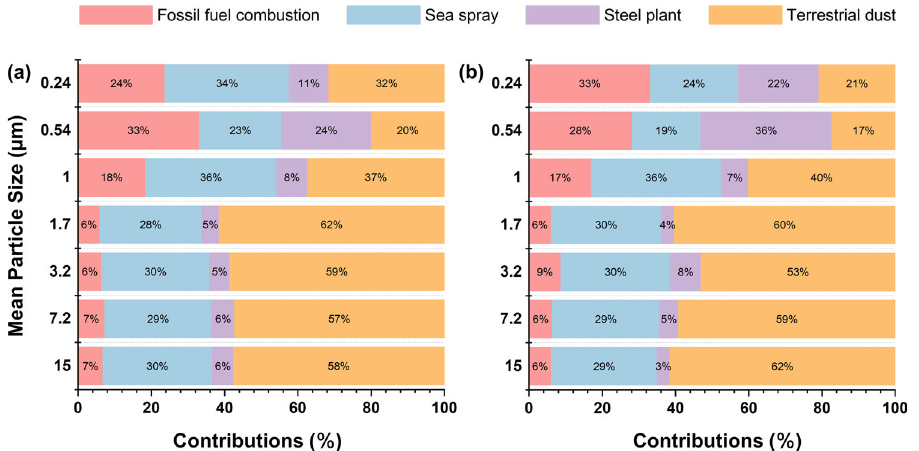
Fig. 4 Iron source apportionment results based on model calculations with iron isotope ratios of size-segregated aerosols in Hiroshima, Japan. Stacked bars show the results of a March and b August aerosol samples, respectively. Original data of Hiroshima size-segregated aerosol samples are from Kurisu et al. 148 .